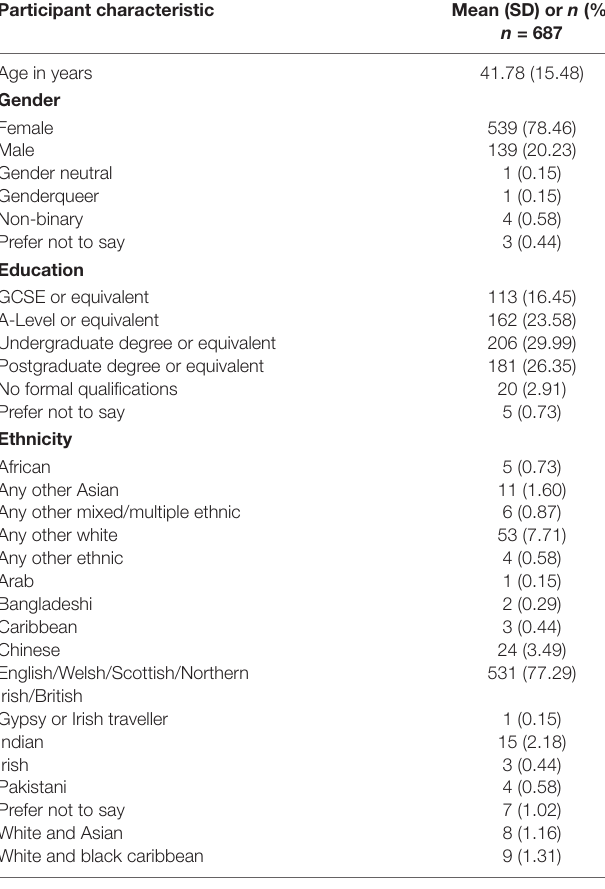
TABLE 1 | Participant characteristics. TABLE 2 | Participant mental health and smoking information. Participant mental health and smoking